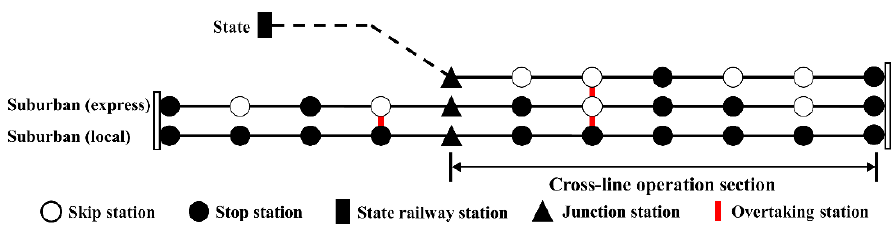
Figure 2. Train stop plan.